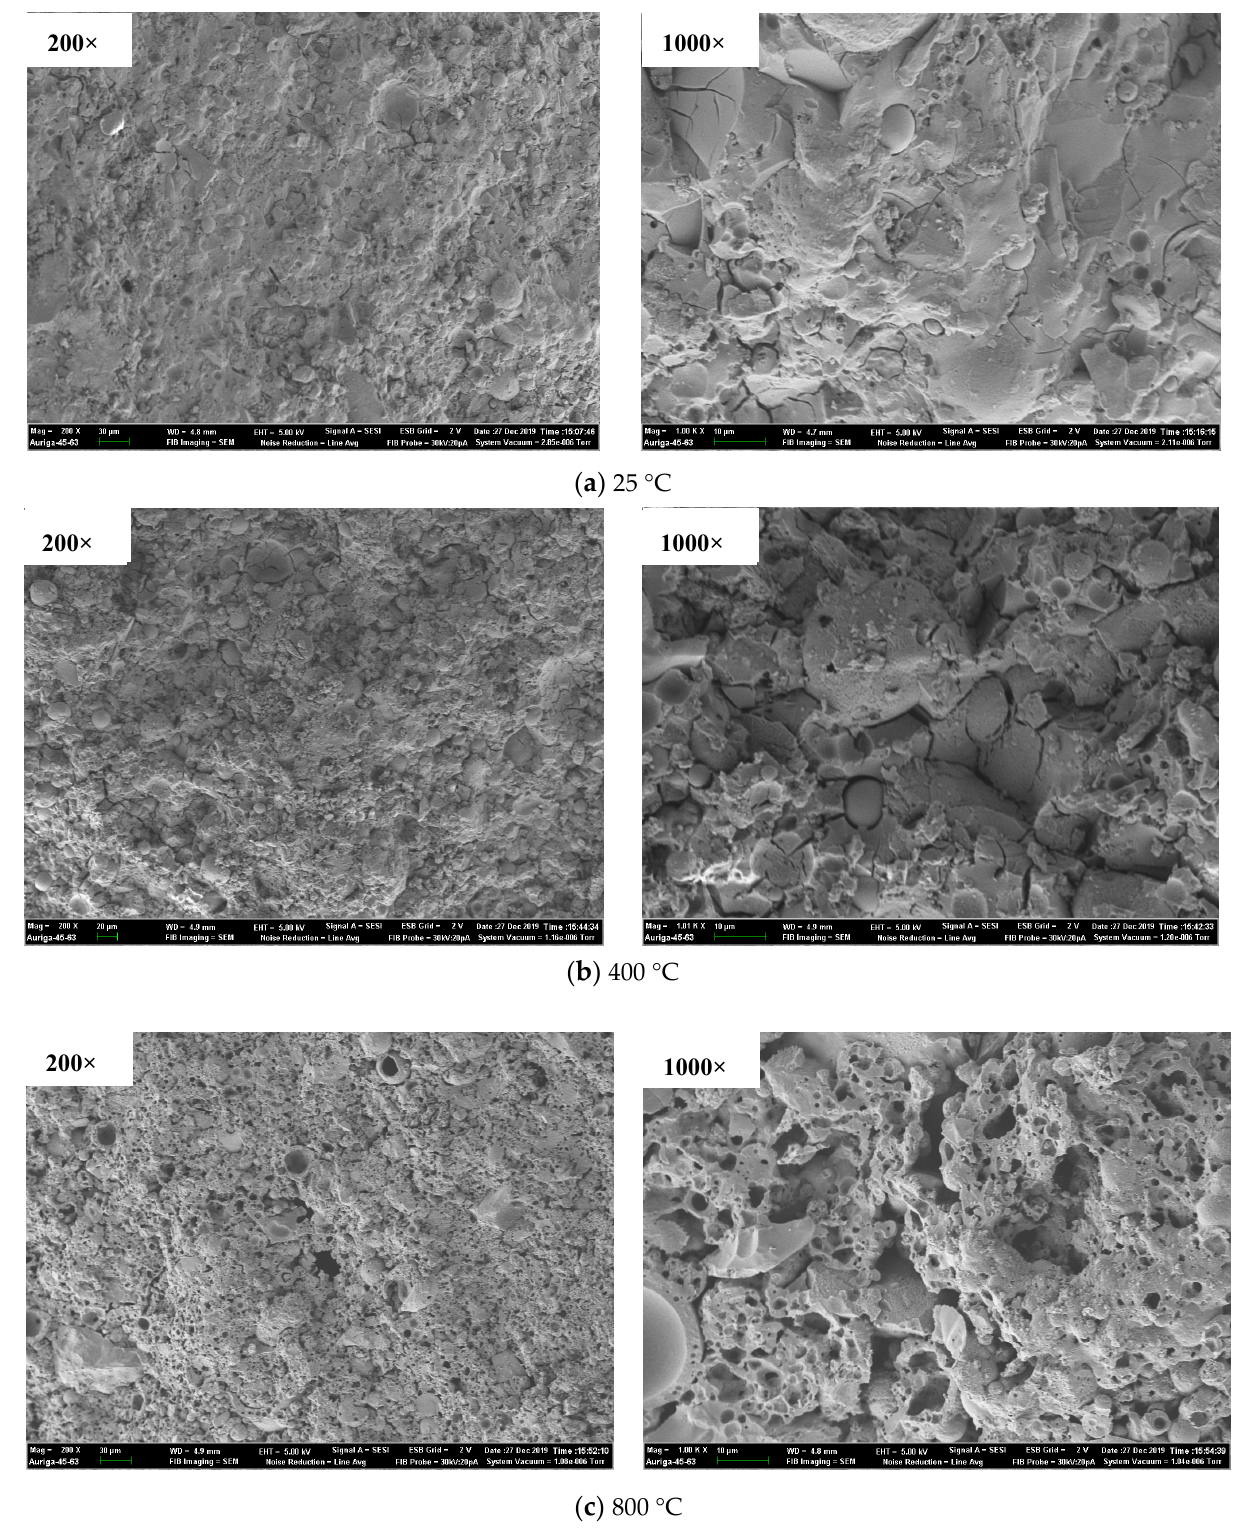
Figure 16. SEM result of GP-C40 after exposure to elevated temperature.